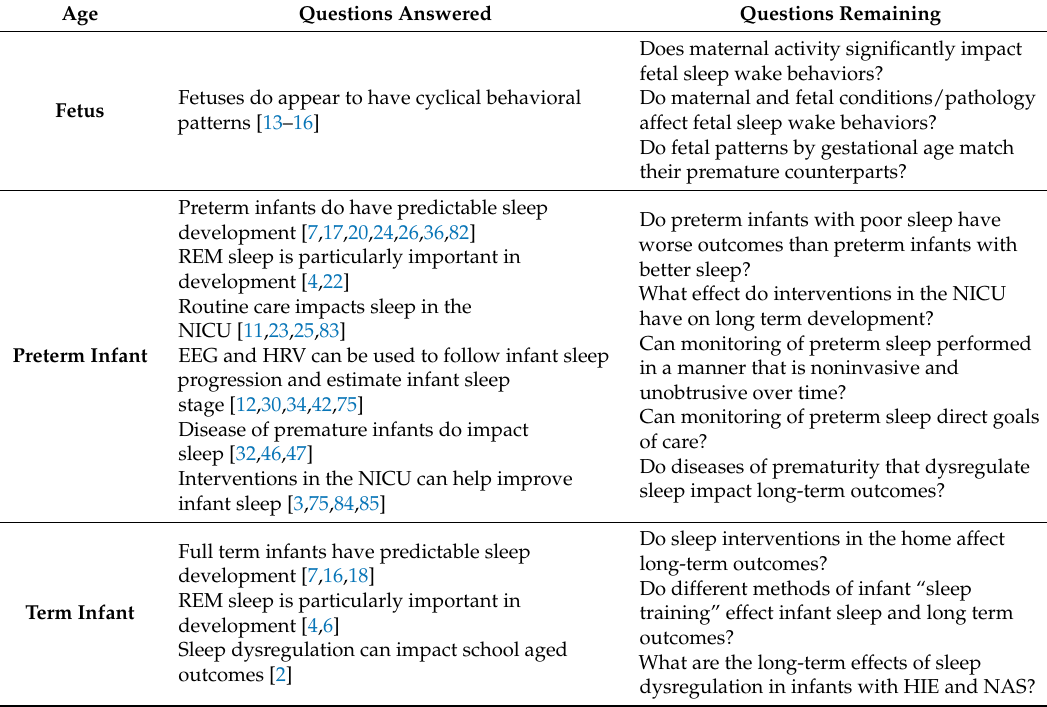
Table 3. Research questions answered and research questions that remain, regarding neonatal